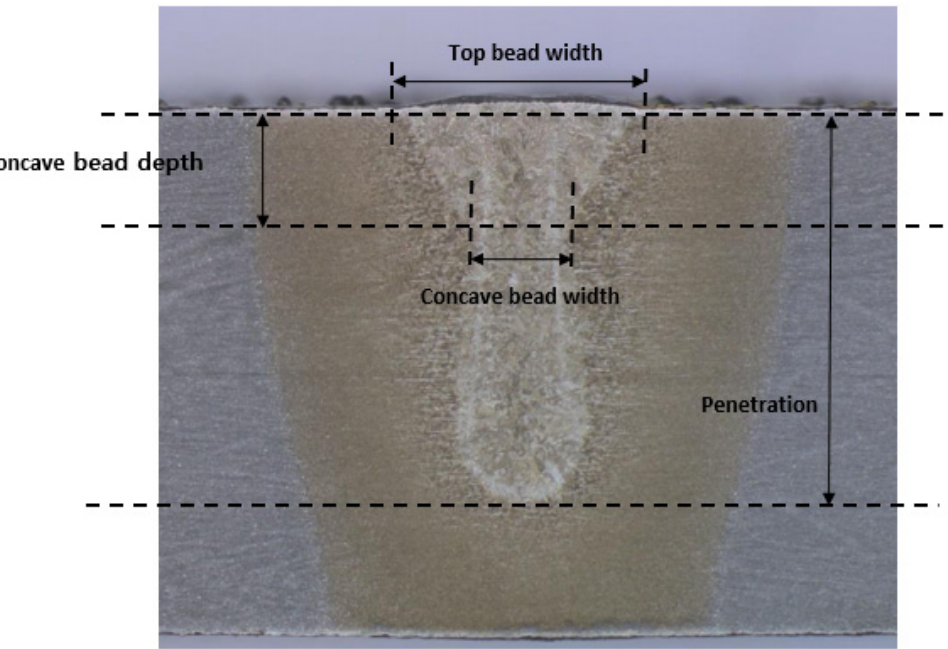
Figure 4. Welding bead shape and dimension.